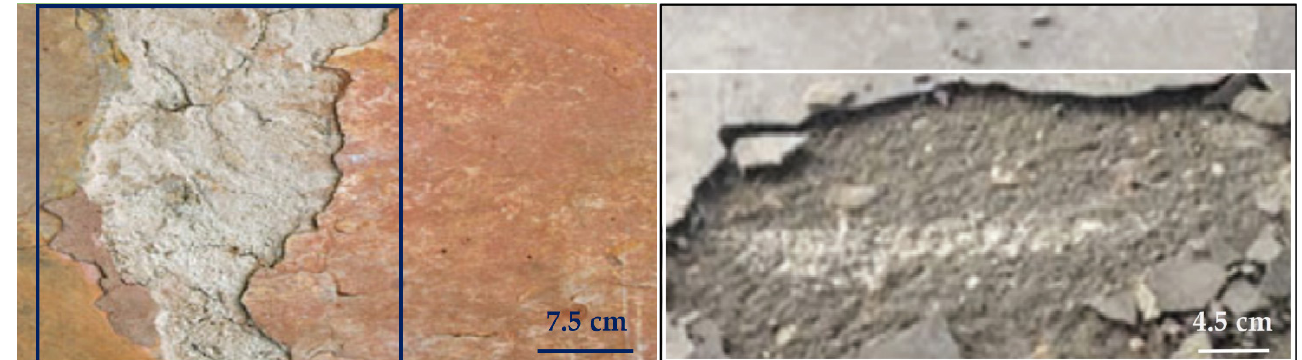
Figure 3. Sample images of delamination defects in concrete with scale bar.